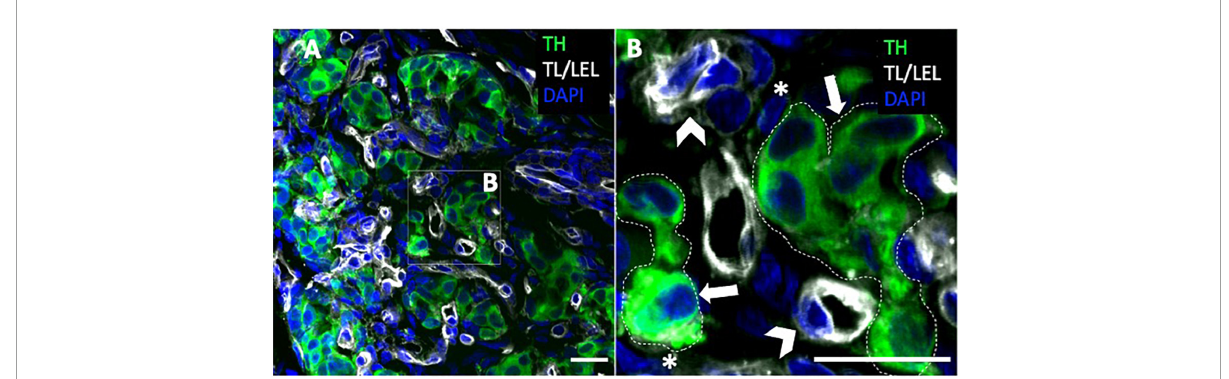
FIGURE2 Carotid body type I and type II cells. (A,B) Immunohistochemistry of rat carotid body with glomus cell marker (TH) depicting clusters of type I cells. Blood vessels are associated with tomato lectin/lycopersicon esculentum lectin (TL/LEL) signal. Magnified panel selected to highlight the type II cells and type I cell clusters. Arrowheads – blood vessels; asterisk – type II cell; thick arrows – type I cell. Scale bar –20 µ m. DAPI indicates 4’,6-diamidino-2-phenylindole; and TH, tyrosine